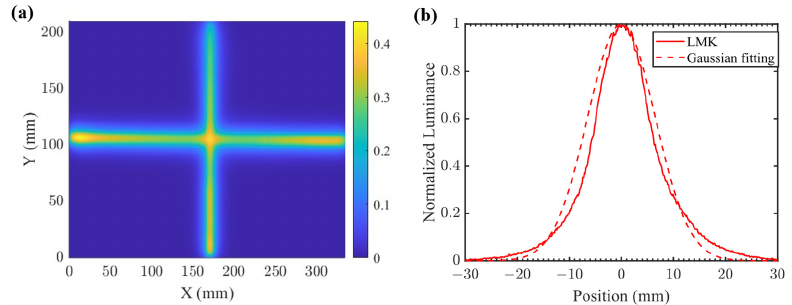
Figure 10. ( a ) Two-dimensional luminance distribution for the backlight. ( b ) One-dimensional luminance profile. According to Figure 10a, the luminance distributions along two perpendicular lines